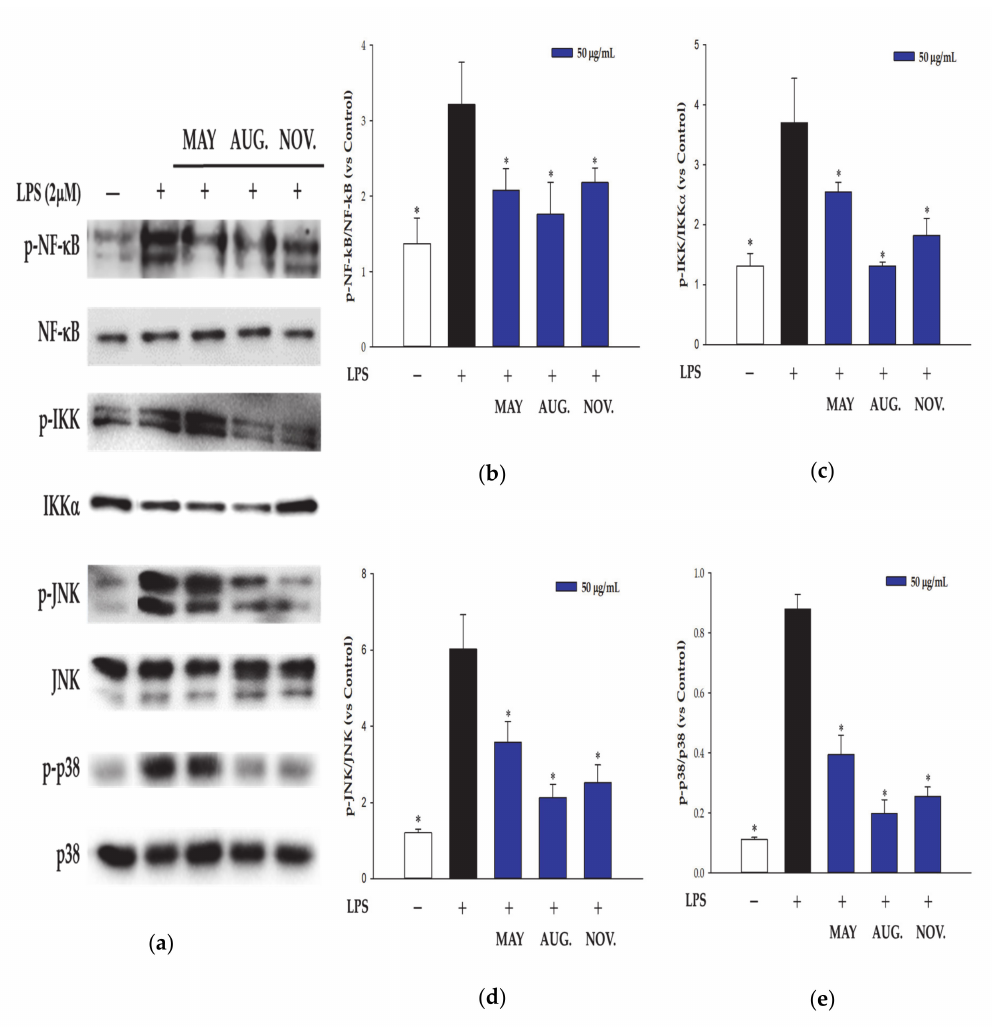
Figure 5. The e ff ect of Dendropanax morbifera extracts on the nuclear factor κ B and mitogen-activated protein kinase signaling pathways. Western blotting bands for the phosphorylation of proteins ( a ) and quantification of the band intensity on nuclear factor κ B (NF- κ B) ( b ), I κ B kinase α (IKK α ) ( c ), c-Jun N-terminal kinase (JNK) ( d ), and phosphorylated p38 MAPK (p38) ( e ). W100, hot